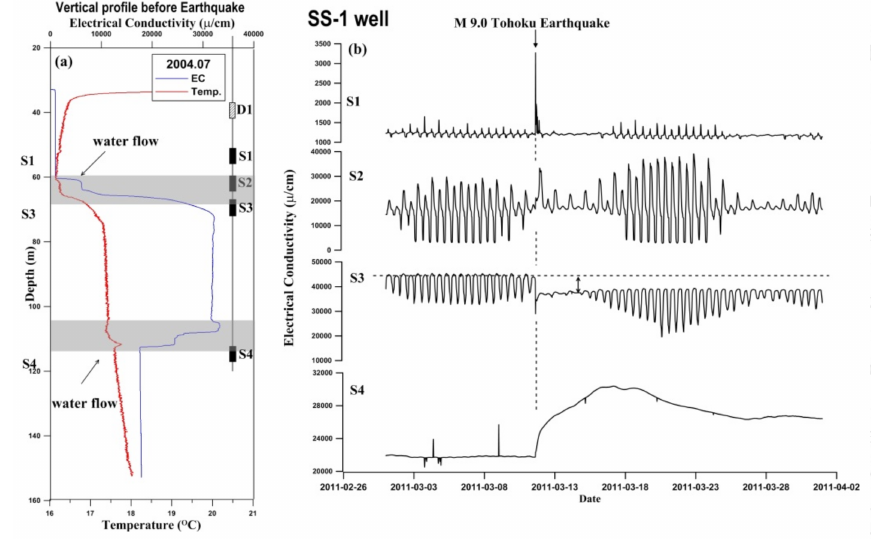
Figure 9. The EC responses by the earthquake at S1, S2, S3, and S4 depths in well SS-1. Table 4. Electrical conductivity (EC) and temperature changes at S1, S2, S3, and S4 depths in well